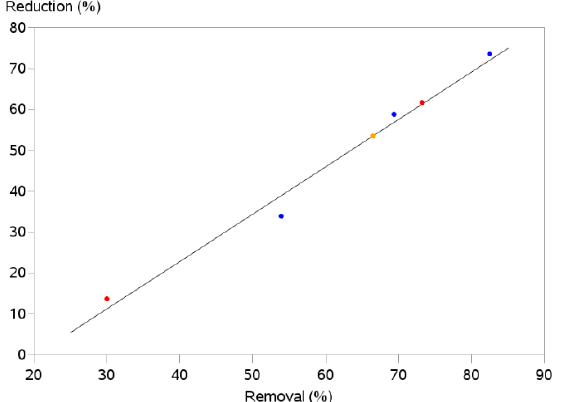
Figure 5. Results from experiments 1278 (red dots) and 1289 (yellow dot) in Sweden and an experiment (blue dots) in Canada [35] summarized in a simple model for the reduction in stand volume growth ( Red Iv% ) as a linear function of thinning removal ( Rem V% ), both expressed as a percentage of the unthinned control. Excluding point thinning, for which the selection criteria differ substantially, the following model was calibrated (black line): Red Iv% = − 23.67 + 1.16 · Rem V% ( R 2 = 0.980***, n = 6, calibration range: 30-83%).